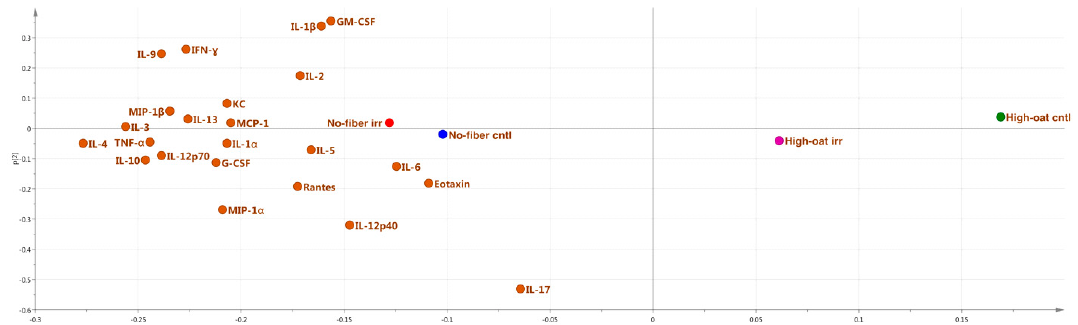
Figure 3. Principal component analysis (PCA), a multivariate dimensionality reduction analysis was performed on serum cytokines and chemokines levels in mice at 1 week post-irradiation. ( A ) PCA score scatter plot of cytokine profiles, showing discrimination between the groups. ( B ) PCA loading scatter plot showing the associations between the cytokines and different groups.